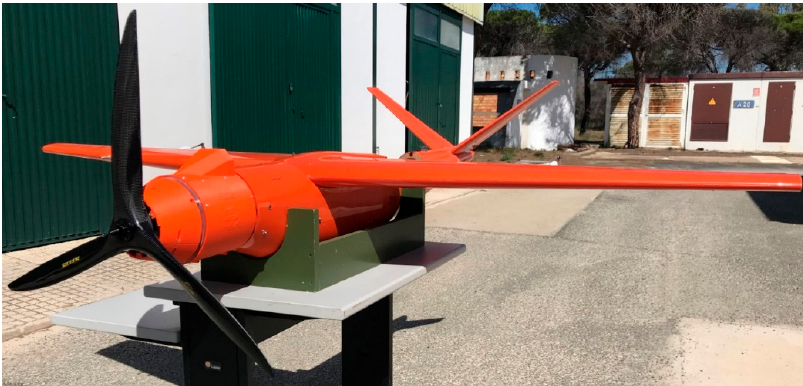
Figure 27. Electric ALO unmanned aerial vehicle ready to fly.